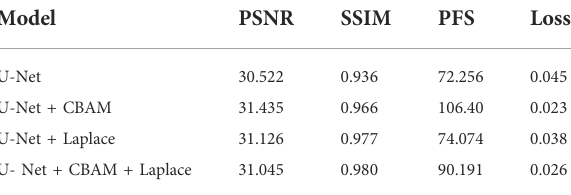
TABLE 1 Model performance veri fi